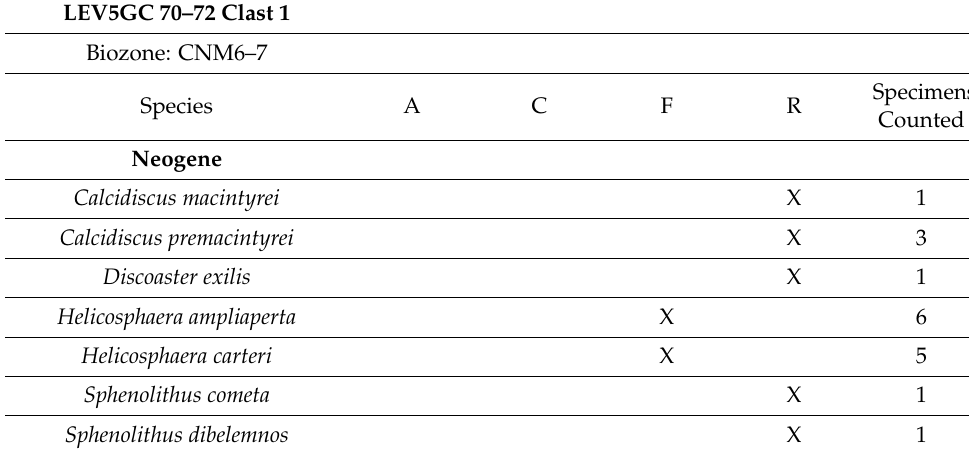
Table A22. Moscow